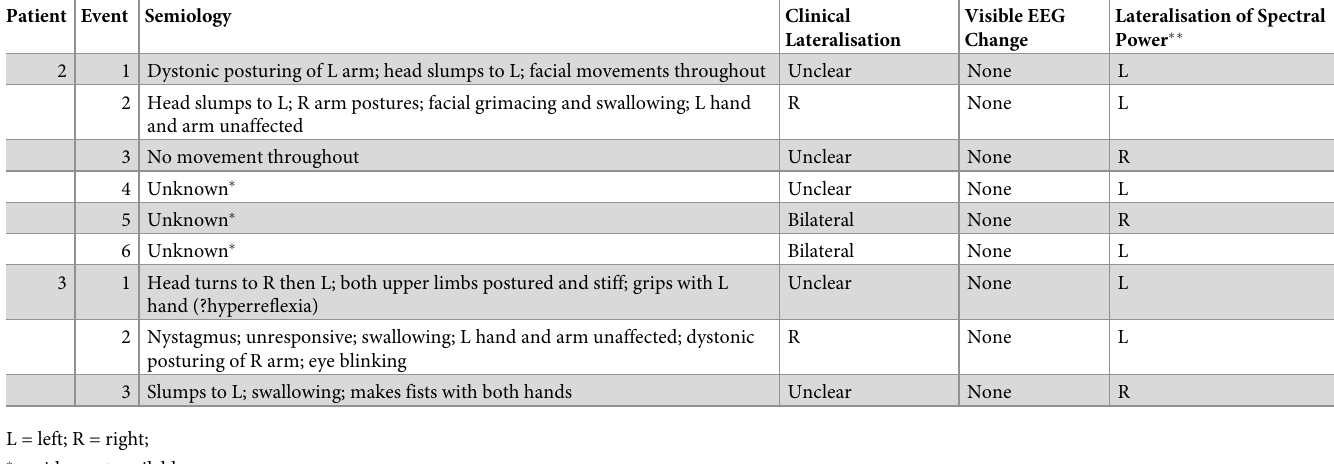
Table 2. Clinical and EEG features and lateralisation of hemiplegic